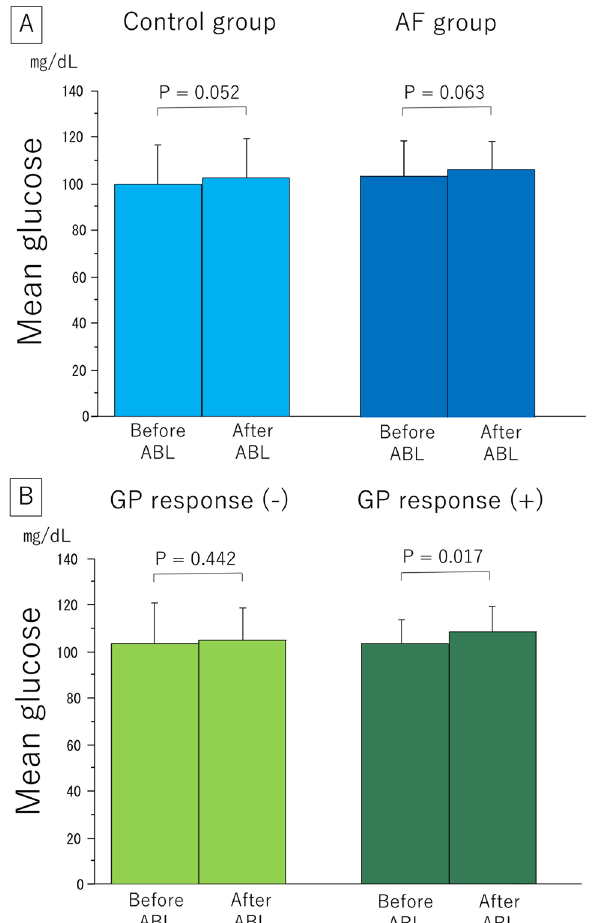
Figure 2. ( A ) The mean absolute change in the glucose level before and after ablation. ( B ) In the AF group, the mean glucose level was separately assessed in patients with and without GP responses. ABL ablation, AF atrial fibrillation, GP ganglionated